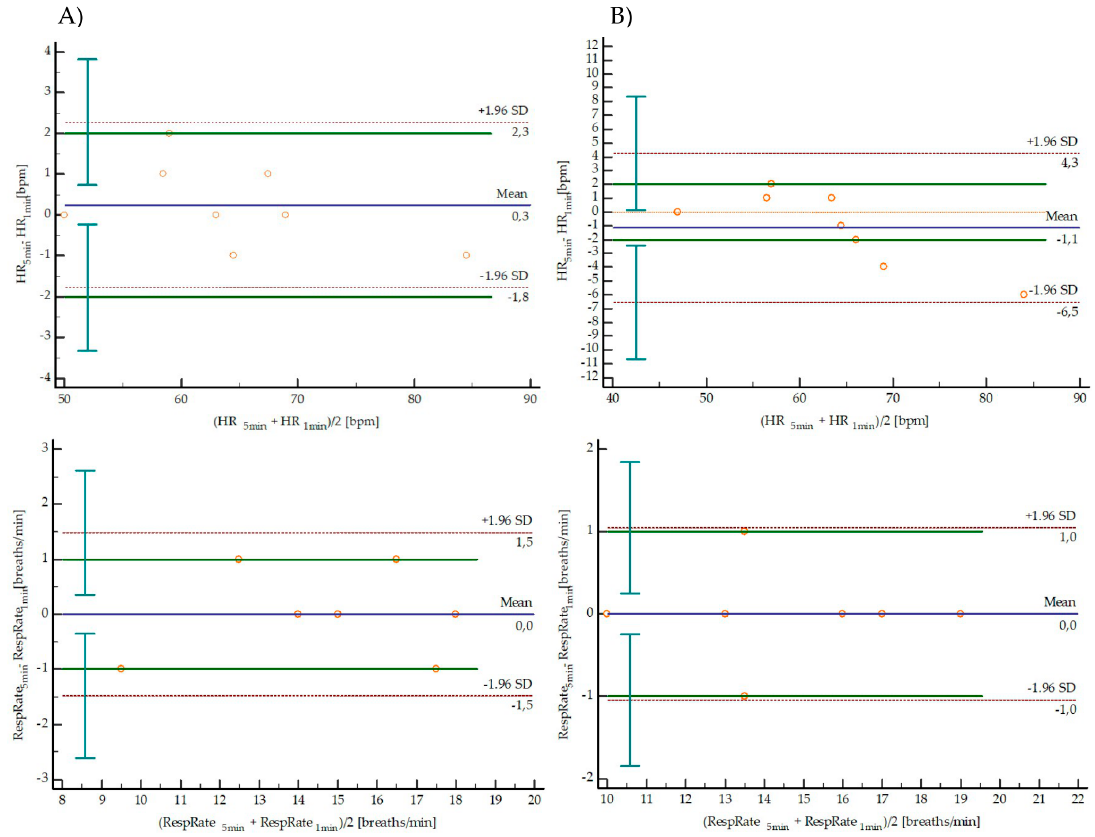
Figure 2. Bland–Altman plots representing the agreement between the 1 min and 5 min in HR and RespRate in both Test (column A ) and Retest (column B ) periods. The solid blue line indicates the bias, dotted red lines are the 95% LoA (±1.96 SD), vertical lines are confidence interval LoA limits, solid green lines are a priori defined maximum allowed difference.